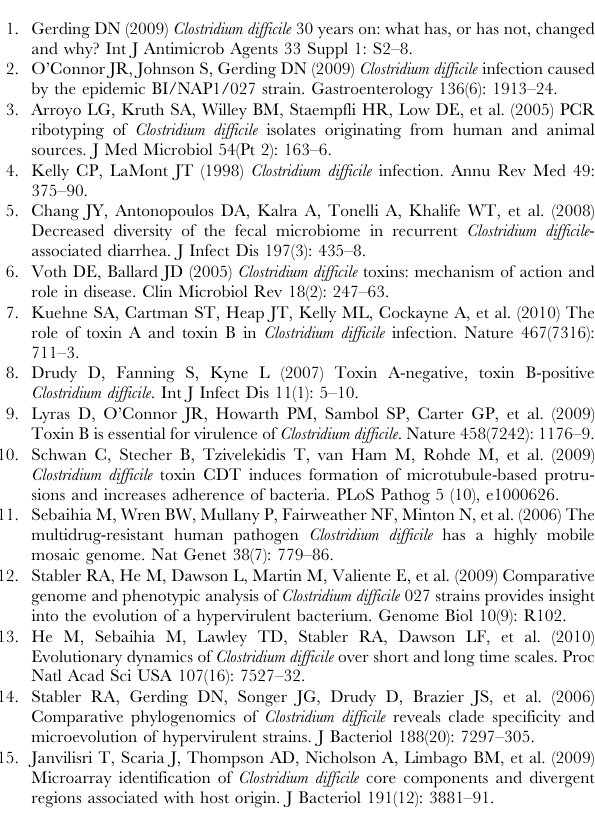
Figure S1 Functional interaction network of differen- tially expressed proteins in C. difficile following the in vivo incubation. Nodes are either colored (linked) or white (nodes of a higher iteration/depth). Edges, i.e. known and predicted functional links consist of recurring neighborhood (green), gene-fusion events (red), phylogenetic co-occurrence (blue), co-expressions (grey), biochemical data (pink), evidence from databases (light blue) and text mining (yellow). Table S1 A list of differentially expressed proteins identified in this study and their expression levels in response to in vivo conditions compared to the in vitro growth. The positive and negative values of the means represent up- and down-regulation, respectively. These proteins are classified according to their clusters of orthologous groups. File S1 All protein and peptide data are available as spreadsheets. The tables list the identified proteins with